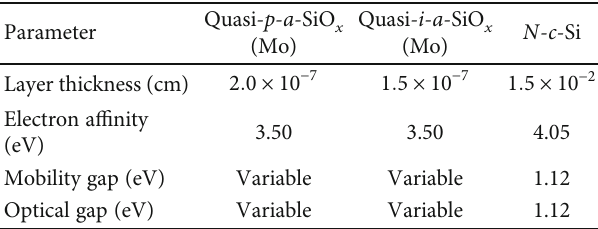
Table 1: Simulation parameters of the interfacial layer in the MSHJ solar